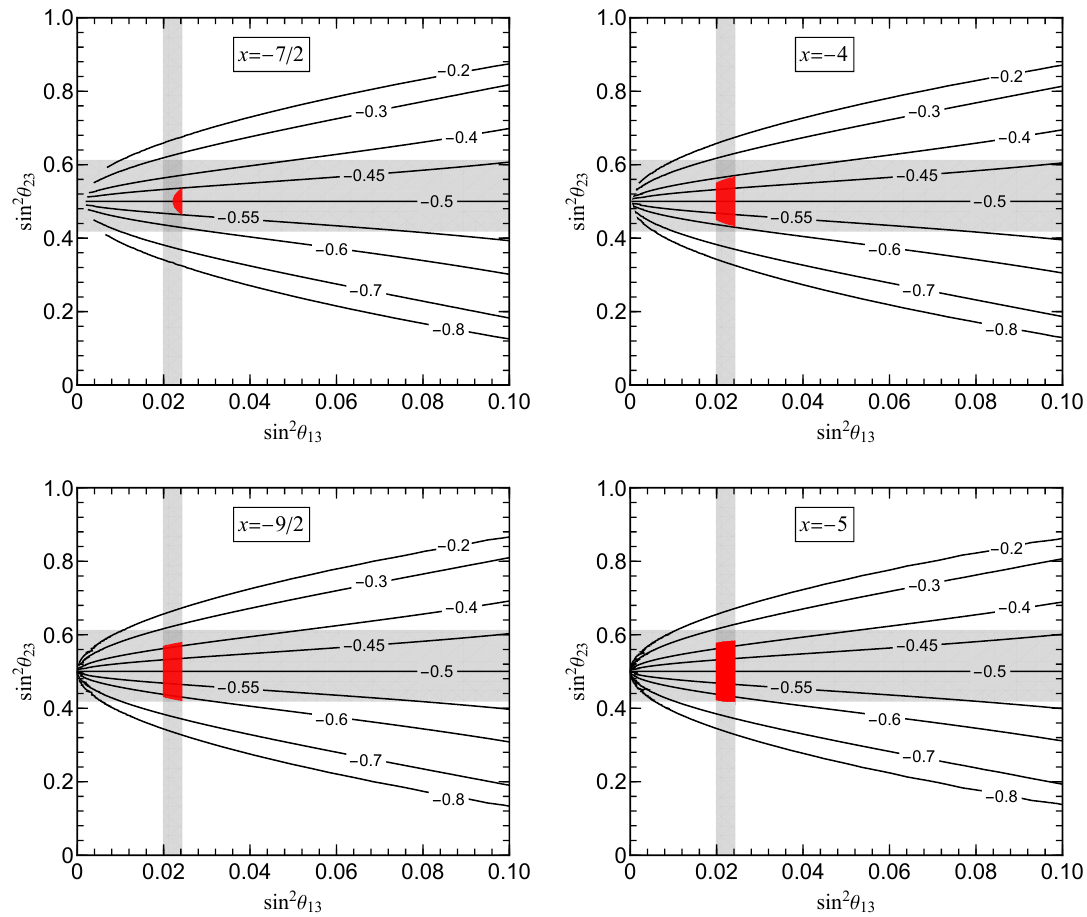
Figure 3 . Contour plot of (cid:14) CP =(cid:25) in the sin 2 (cid:18) 13 (cid:0) sin 2 (cid:18) 23 plane for the benchmark values of x = (cid:0) 7 = 2 ; (cid:0) 4 ; (cid:0) 9 = 2 ; (cid:0) 5. The contour lines are obtained by using the sum rule in eq. (4.24). The gray bands represent the experimentally preferred 3 (cid:27) ranges of the mixing angles adapted from [4]. The red areas in the plane are the most generally allowed regions of sin 2 (cid:18) 13 and sin 2 (cid:18) 23 for given value of x , where the four input parameter m a , m s and (cid:17) are randomly chosen and the resulting mixing angles and mass squared di(cid:11)erences are required to lie in the experimentally preferred 3 (cid:27) regions